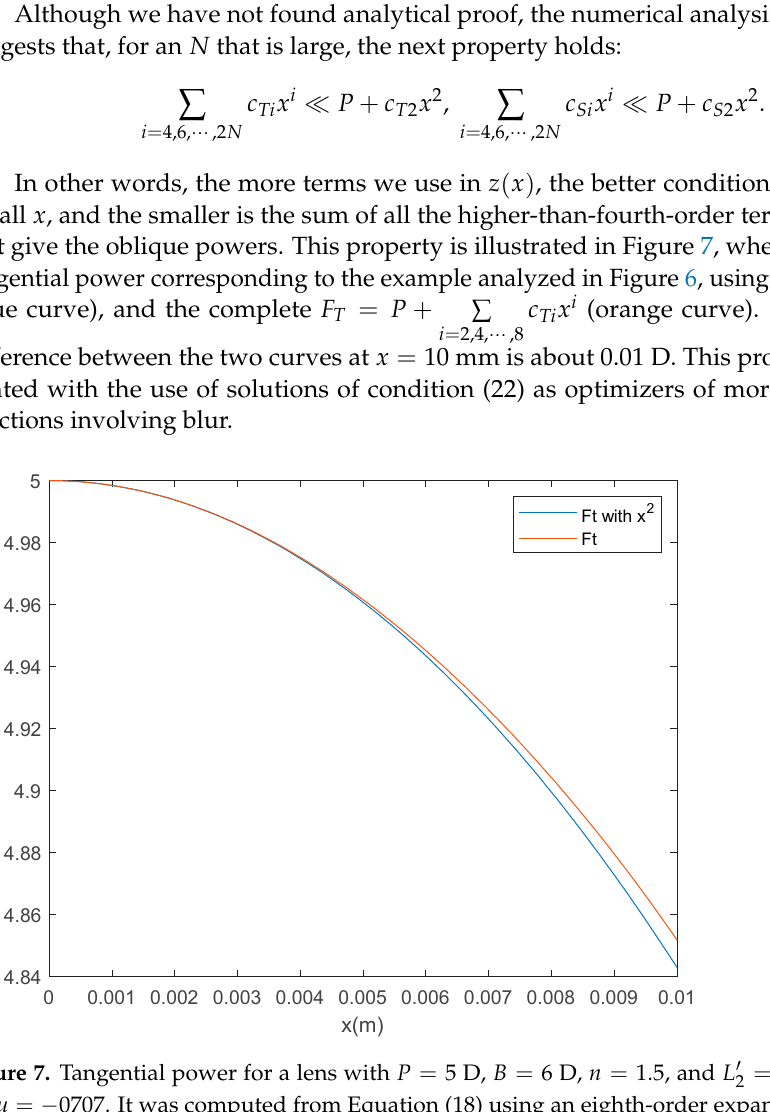
Figure 7. Tangential power for a lens with 𝑃 = 5 D, 𝐵 = 6 D, 𝑛 = 1.5 , and 𝐿 (cid:2870)(cid:4593) = 37 D, computed for 𝑢 = −0707 . It was computed from Equation (18) using an eighth-order expansion for the back surface. The orange line is the tangential power computed with all the terms resulting from (18), while the blue curve has been computed only with the quadratic term.